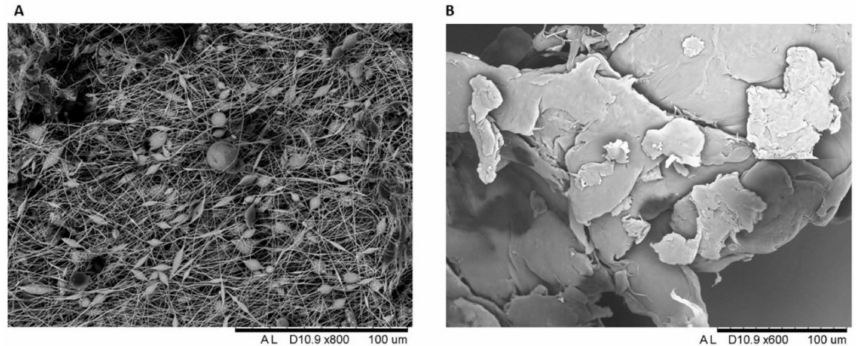
Figure 3. ( A ) SEM images of PVDF and ( B ) PLA after